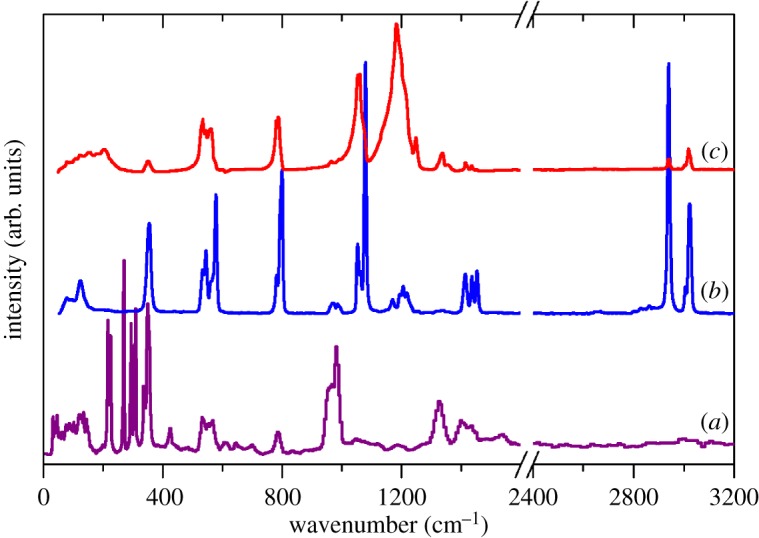
(a) INS, (b) FT-Raman and (c) infrared spectra of Na(CH3SO3).